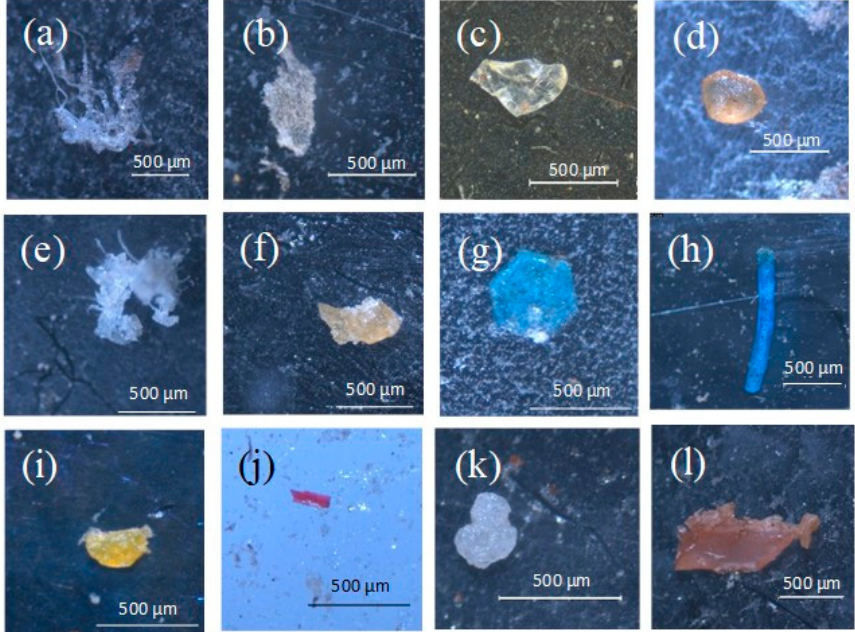
Figure 2. Microlitter ( a – d ) and microplastics ( e – l ) in “La Aljorra” WWTP: ( a ) cellulose (INF/1 August 2019); ( b ) chipboard (INF/20 February 2020); ( c ) silicic acid, sodium salt (EFF/20 February 2020);